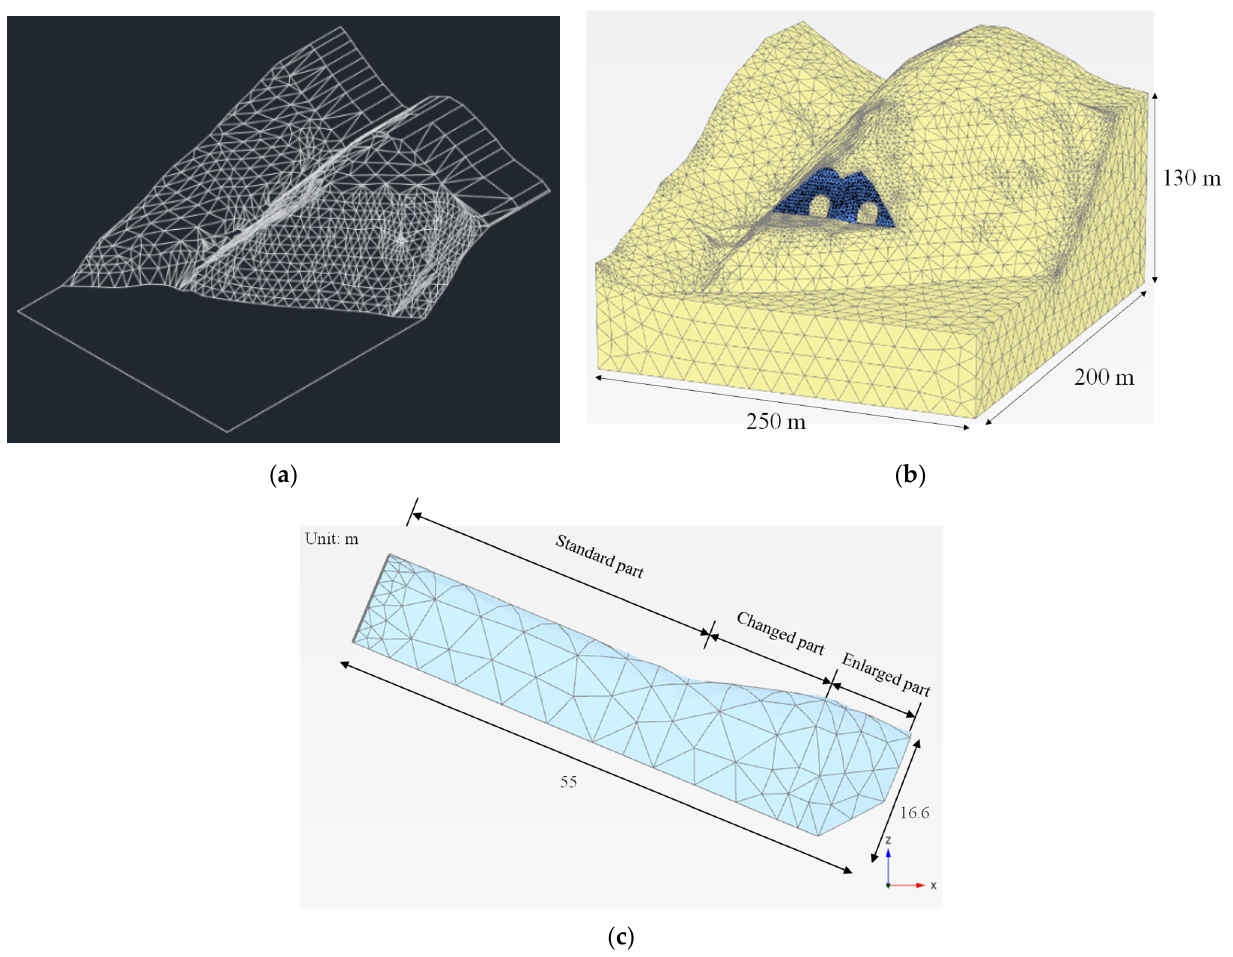
Figure 2. A typical 3D model for FE analysis: ( a ) design drawings, ( b ) mountainous area, and ( c ) anchorage.